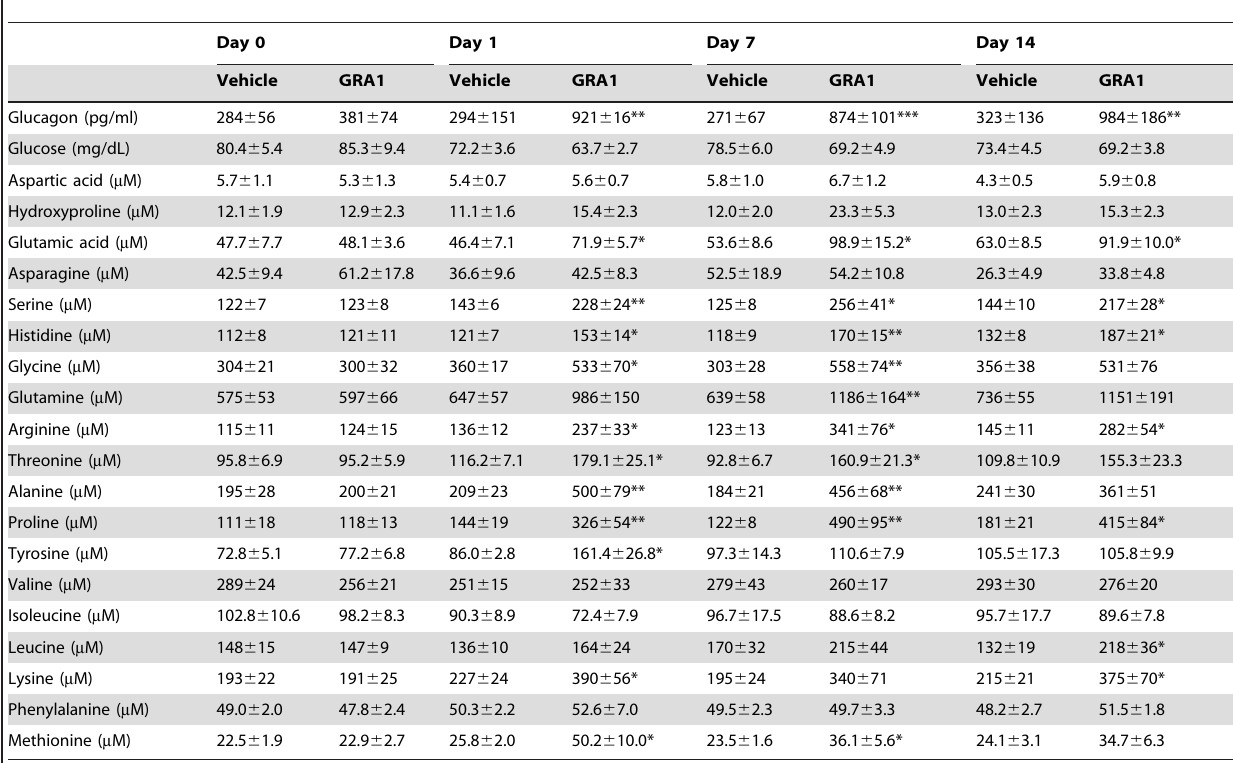
Table 6. Fasted plasma glucagon, glucose and amino acids in rhesus monkeys treated once daily with vehicle or 30 mg/kg